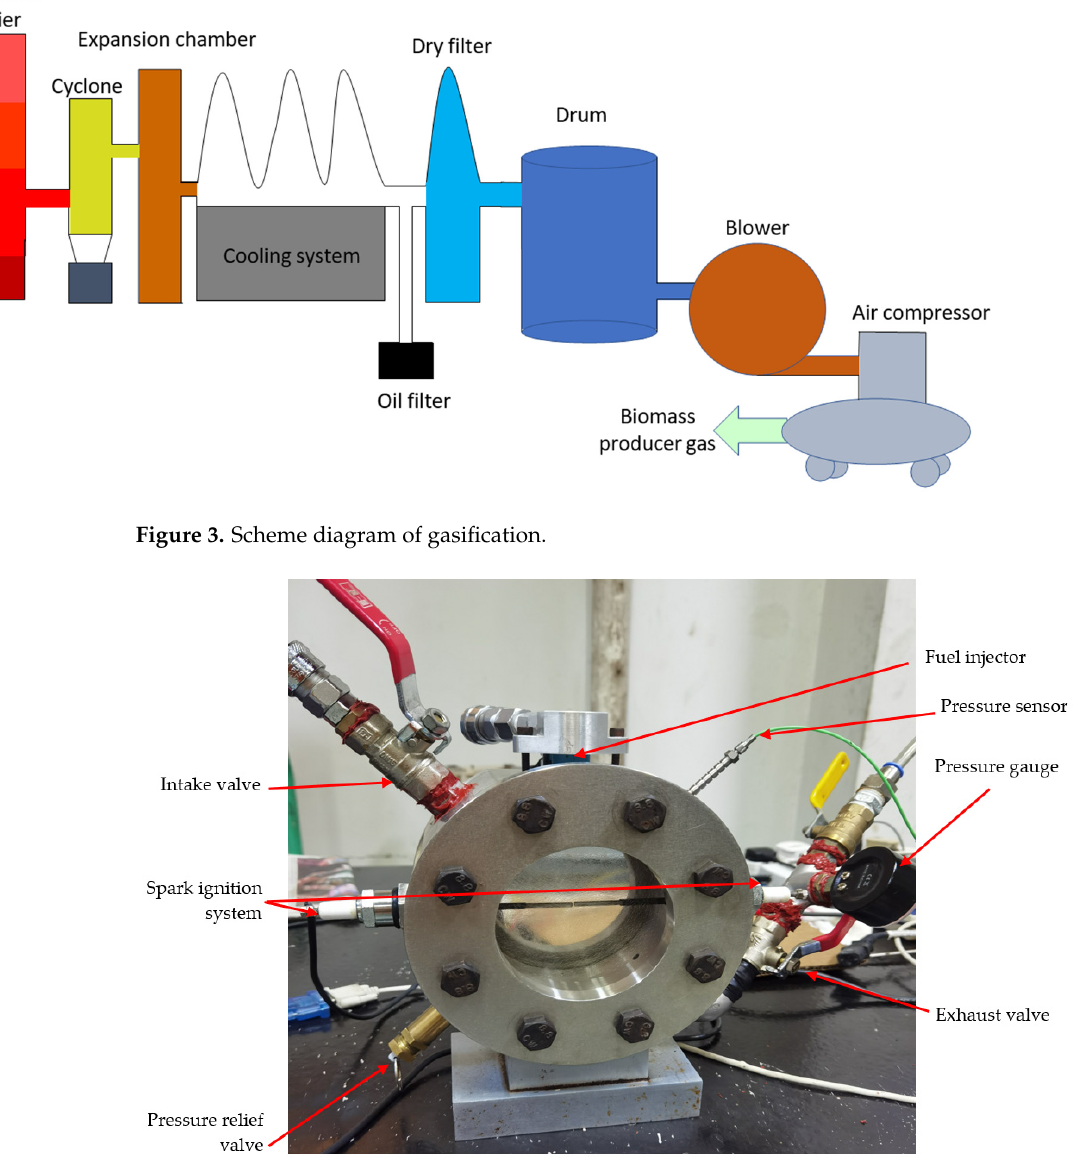
Figure 3. Scheme diagram of gasification.